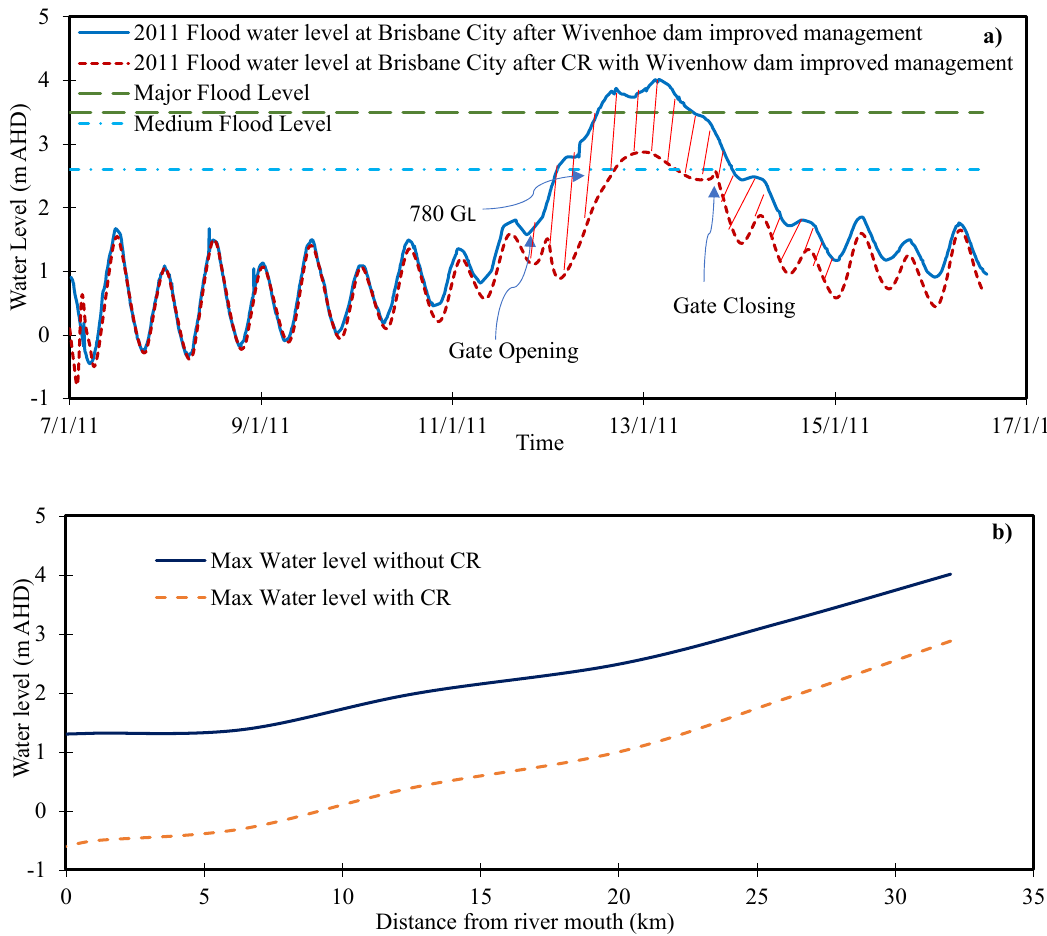
Figure 13. ( a ) Comparison of water level for 2011 flood event at Brisbane City for optimum water level reduction under improved management of Wivenhoe dam ( b ). Comparison of longitudinal water level profile in BRE with and without CR after improved management of Wivenhoe dam